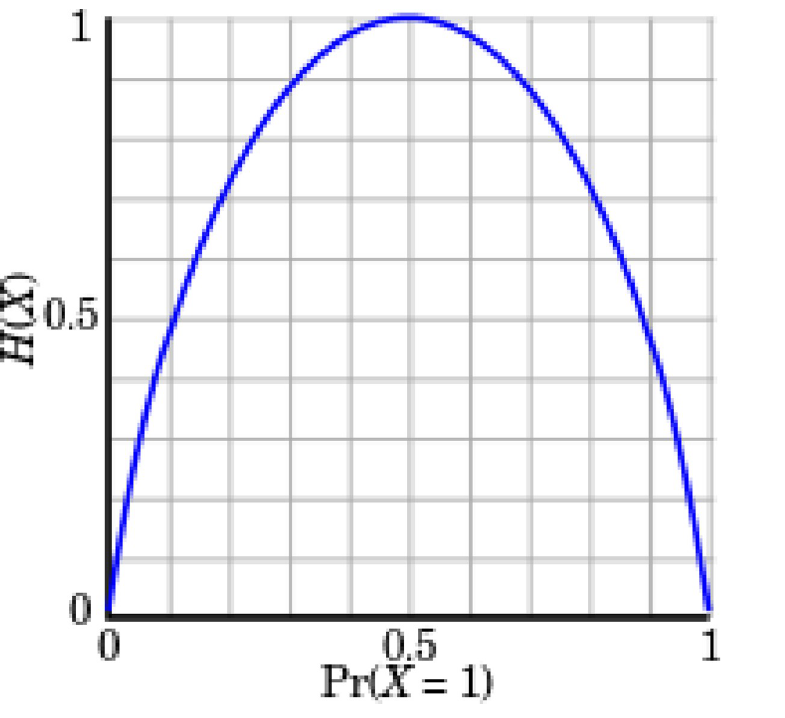
Fig 15. Entropy H(X) vs Probality Pr(X =